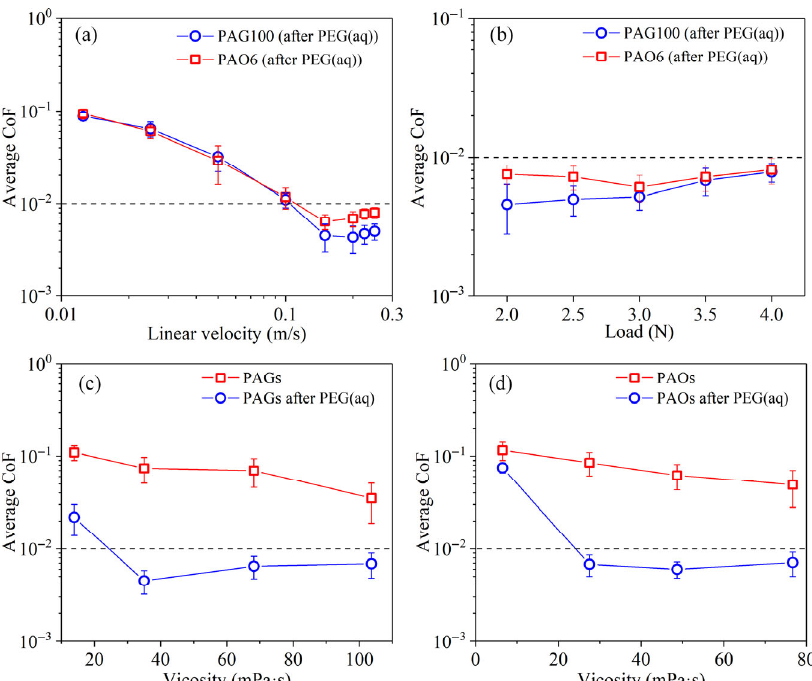
Fig. 2 Average CoFs during the superlubricity periods of (a) PAG100 (and PAO6) with respect to sliding velocity, where the steel/steel friction pairs have been treated by PEG(aq) in advance and the normal load was 3 N; (b) PAG100 (and PAO6) with respect to normal load, where the steel/steel friction pairs have been treated by PEG(aq) in advance and the sliding velocity was 0.2 m/s; (c) the PAGs with respect to viscosity; and (d) the PAOs with respect to viscosity. For (c) and (d), both steel/steel friction pairs that have been treated by PEG(aq) and ones that have not been treated were used, and the normal load and sliding velocity were 3 N and 0.2 m/s,